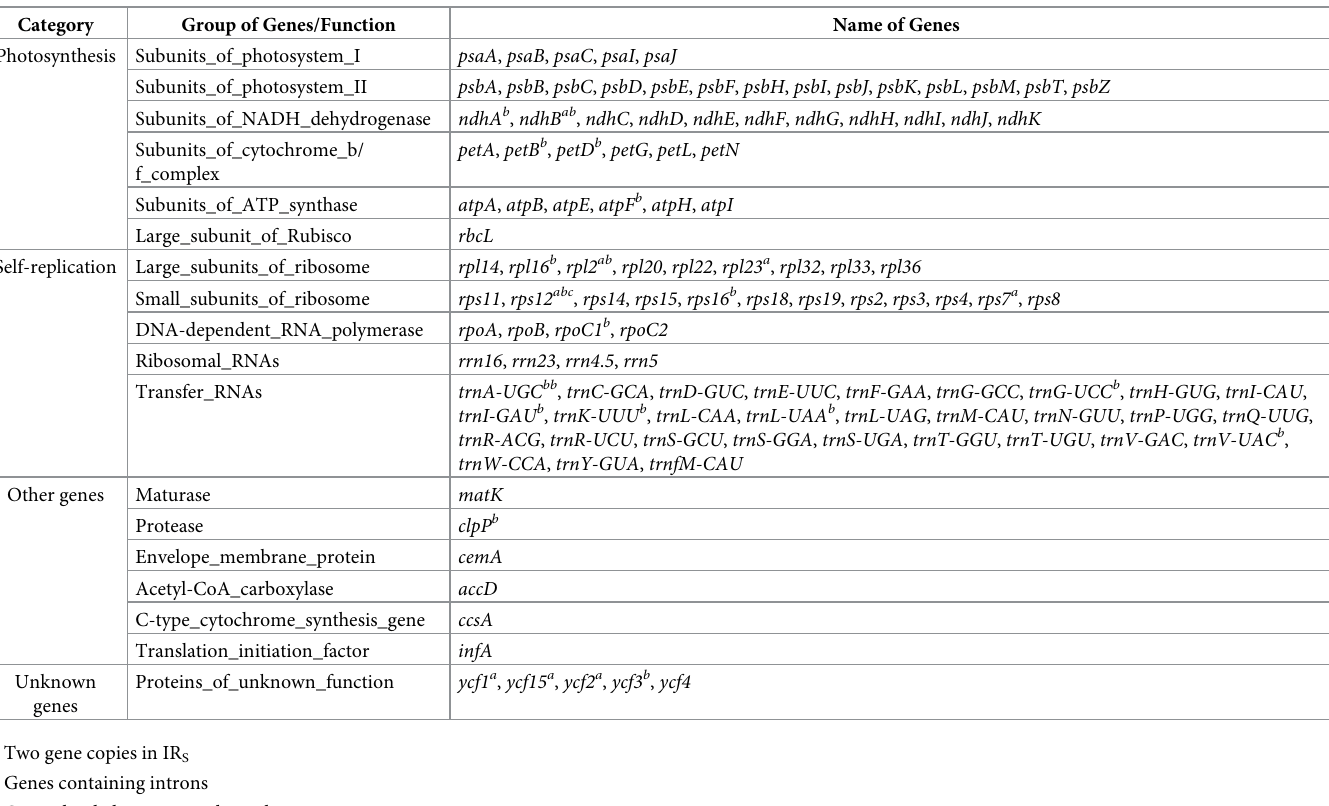
codon usage, or synonymous codon usage, when selective pressure was absent [53]. How- ever, during plant evolution, the pattern of synonymous codon usage usually exhibited pref- erence [54]. Relative synonymous codon usage (RSCU) is used as an effective index to determine codon preference [55]. A RSCU � 1.0 indicates no preference, 1.0 < RSCU < 1.2 signifies a weak preference, 1.2 � RSCU � 1.3 represents a moderate preference, and Table 2. List of genes in the chloroplast genome of I . dabieshanensis .